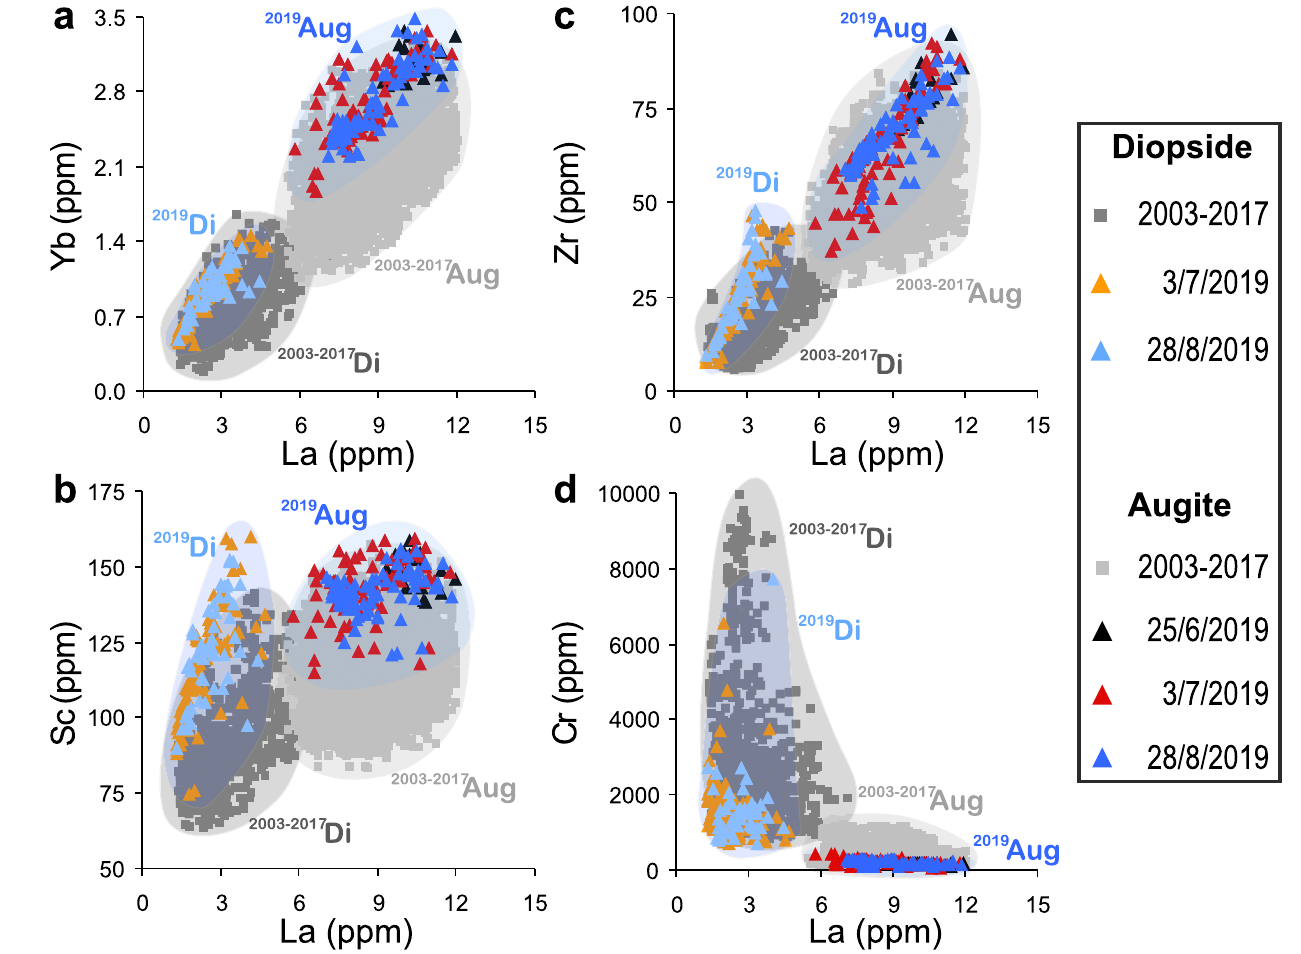
Fig. 6 | Trace elements of 2019 clinopyroxenes. a Yb; b Sc; c Zr, and d Cr vs La (ppm)diagramsshowingthetraceelementsrangeofvariabilityofaugitic(Aug)and diopsidic (Di) portions of the 2019 clinopyroxenes (black triangle: 25 June major explosion;orange and red triangle: 3July paroxysm;and cyanand blue triangle:28